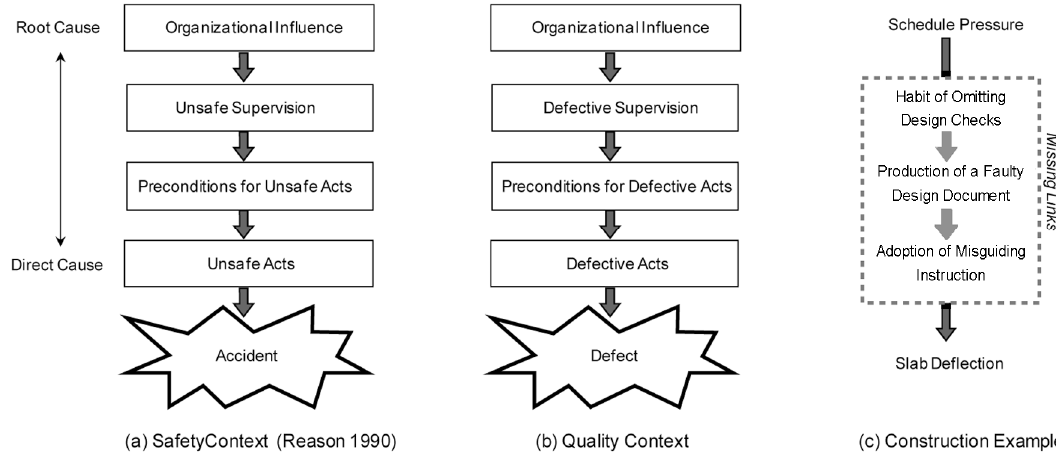
Fig. 1. The missing link between root causes and defects (augmented from Reason